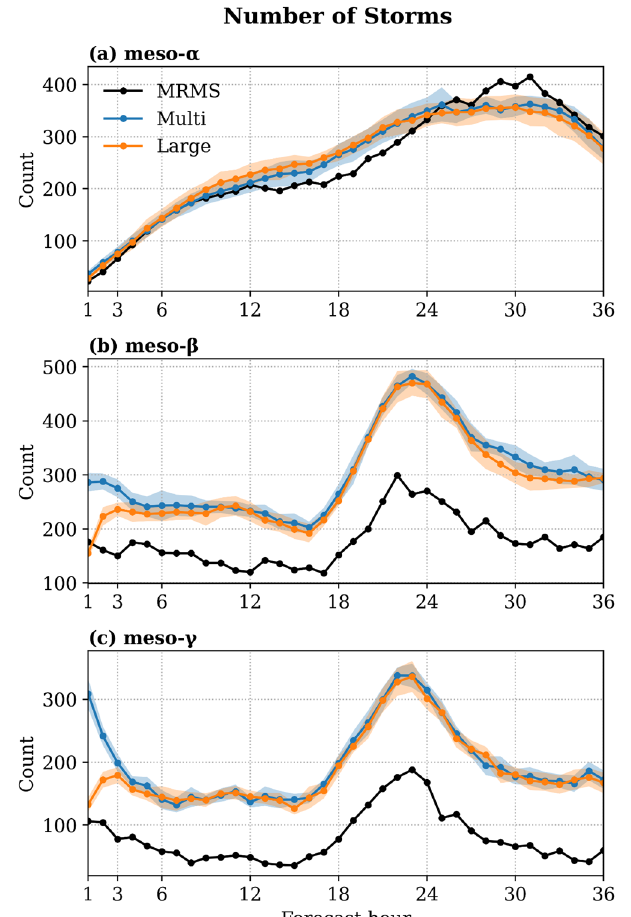
Figure 7. Total number of forecasts and observed storms present at each forecast hour for ( a ) meso-alpha, ( b ) meso-beta, and ( c ) meso-gamma scales for all 25 cases. Blue and orange dotted lines represent ensemble mean storm counts for MULTI and LARGE, respectively, with shades representing one standard deviation range among ensemble members.